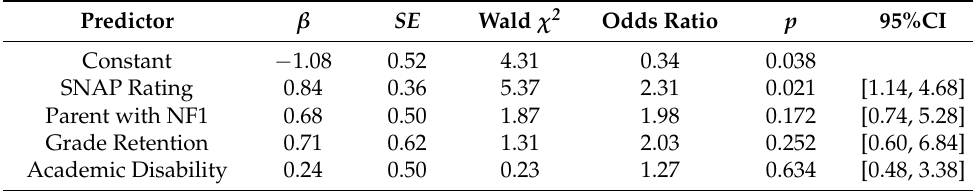
Table 4. Logistic regression analysis of parent report of their child’s bully victimization.